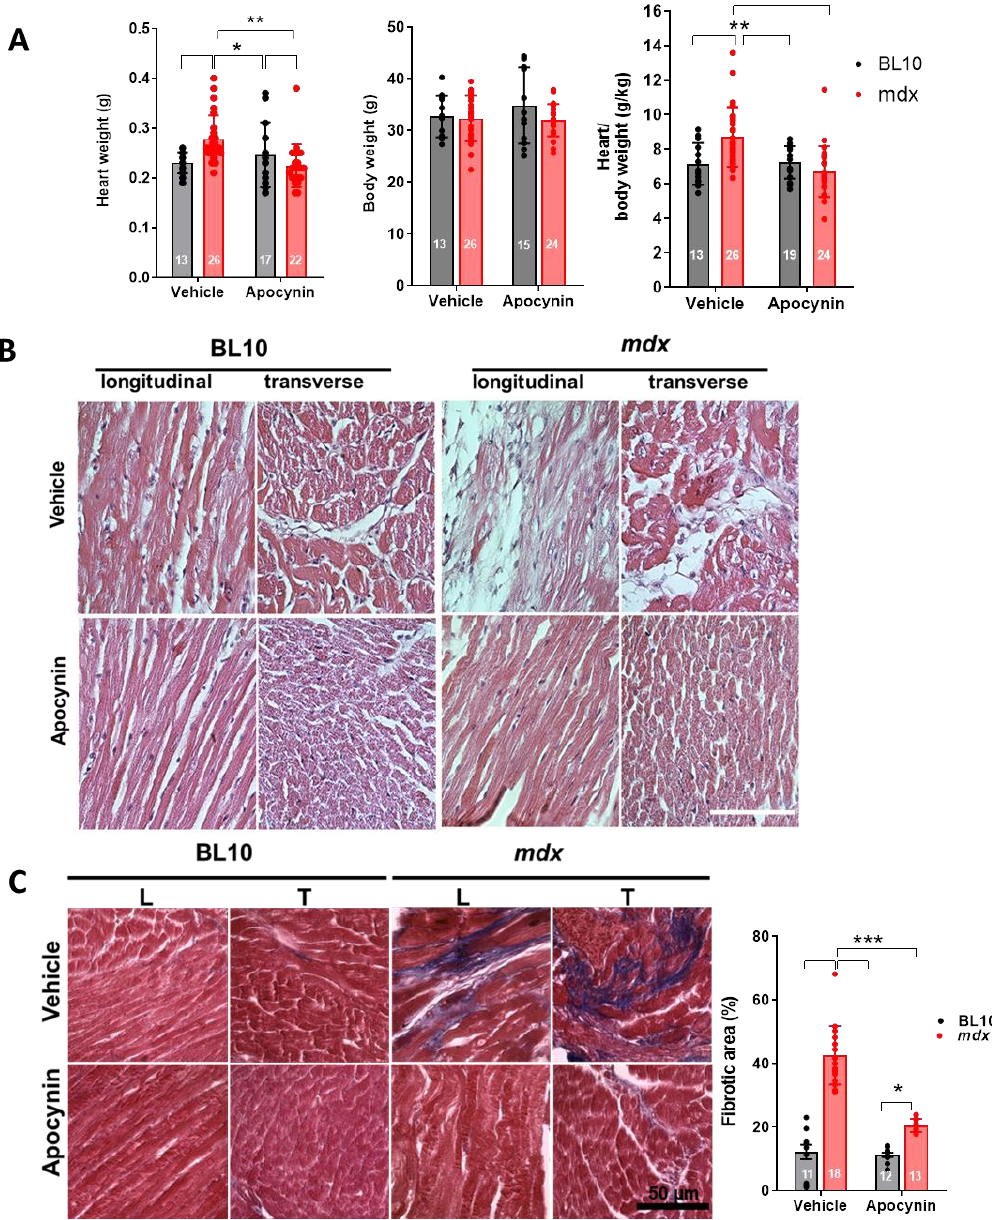
Figure 8. NADPH oxidase inhibition reverses cardiac remodeling in dystrophic hearts. ( A ) Graphs depicting body weight, heart weight and the ratio of heart to body weight in control (BL10) and mdx mice, treated with the vehicle or apocynin for one month. ( B ) Images of hematoxylin and eosin staining for the hearts of 10-month-old control (BL10) and mdx mice treated or not with apocynin, each image representative of 5 hearts. The bar indicates 50 µm. ( C ) Analysis of fibrosis by Masson’s trichrome staining. L, longitudinal sections, T, transverse sections. *, p < 0.05, ** p < 0.01, *** p < 0.001 for the comparisons indicated by the brackets using ANOVA with Newman–Keuls as post-hoc test. The n for each group is indicated inside each bar of the graphs.